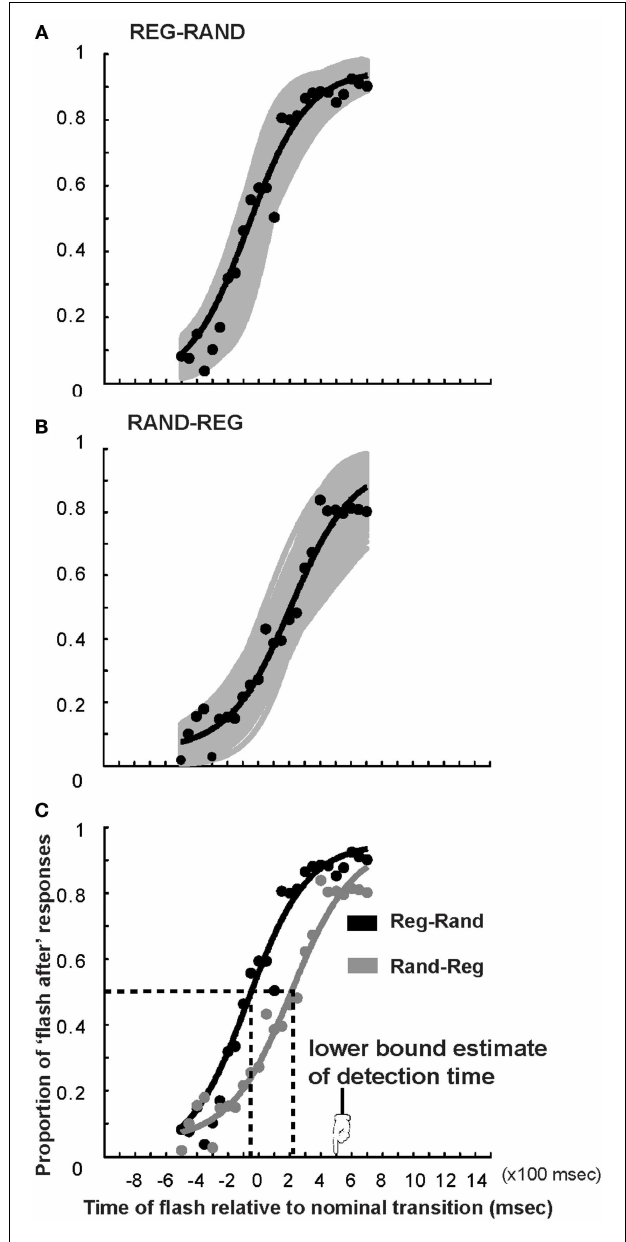
FIGURE 4 | Psychometric fits to theTOJ data in Experiment 2. The x -axis represents the timing of the light flash with respect to the acoustic transition (measured in number of tone pips, multiply by 100 to obtain milliseconds). Negative numbers indicate flash before nominal transition. (A) Proportion of “light flash after” responses for the REG-RAND stimulus averaged over subjects (black circles) and cumulative Gaussian fit (black curve).The gray curves are fits computed over 1000 bootstrap resamplings; their scatter provides a measure of variability across subjects. (B) Same for the RAND-REG transition. (C) Comparison of REG-RAND and RAND-REG psychometric functions.The vertical dashed lines indicate the